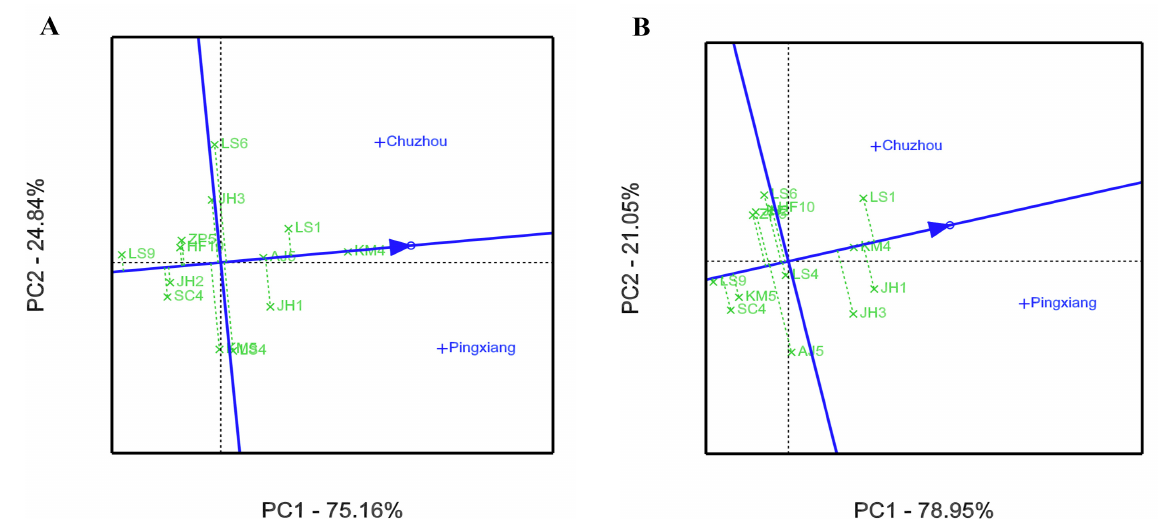
Figure 5. Average environment coordination (AEC) views of the GGE biplot based on environment-focused scaling of C. paliurus genotypes evaluated for tree height ( A ) and diameter at breast height ( B ).